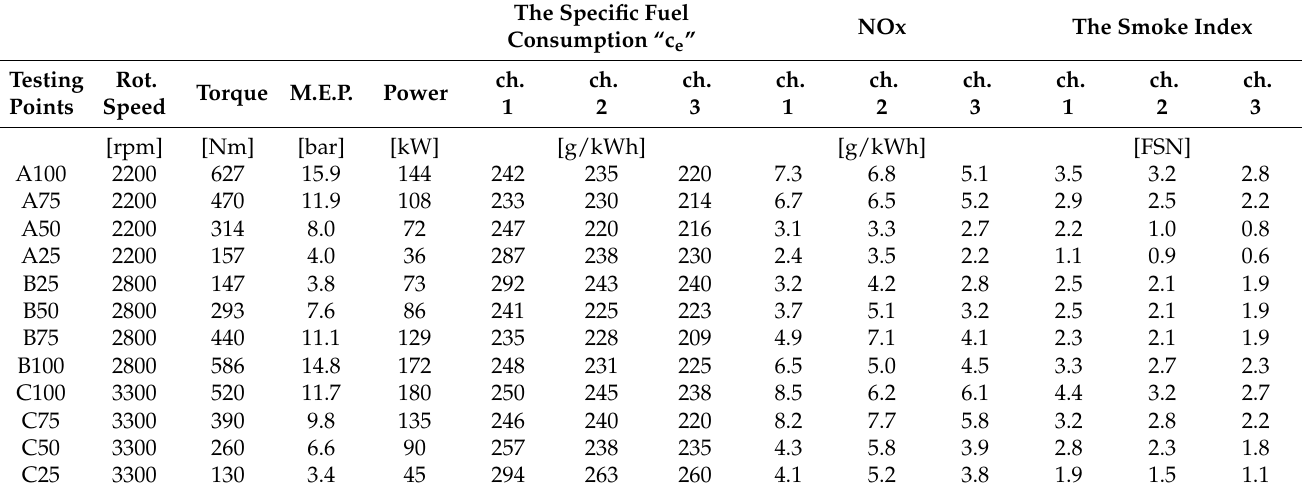
Table 4. Thevaluesoftheenergeticandecologicalparametersdeterminedforthethreecombustionchambers. The Specific